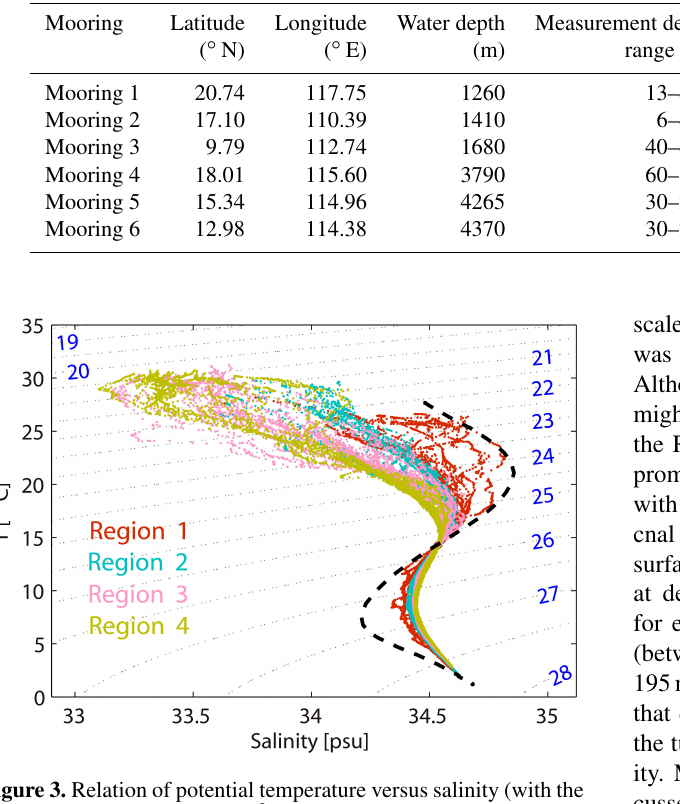
Figure 3. Relation of potential temperature versus salinity (with the potential density σ θ in kgm − 3 contours overlaid) of all stations. The black dashed curve shows the relation for potential temperature versus salinity of the western Pacific for